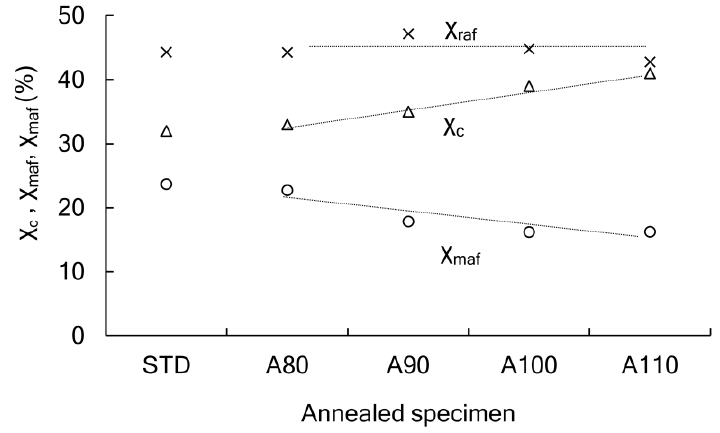
Figure 7. Ratio of crystal (χ c ), mobile amorphous (χ maf ), and rigid amorphous (χ raf ) for annealed PLA after the 1 h hydrolysis at 70 °C and 95% RH.